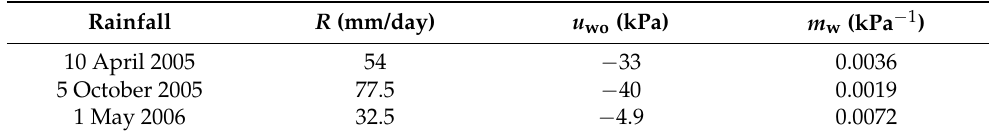
Table 2. Rainfall intensity and initial suction for the events considered in the analyses (data drawn from [50]), along with the corresponding values of m w .